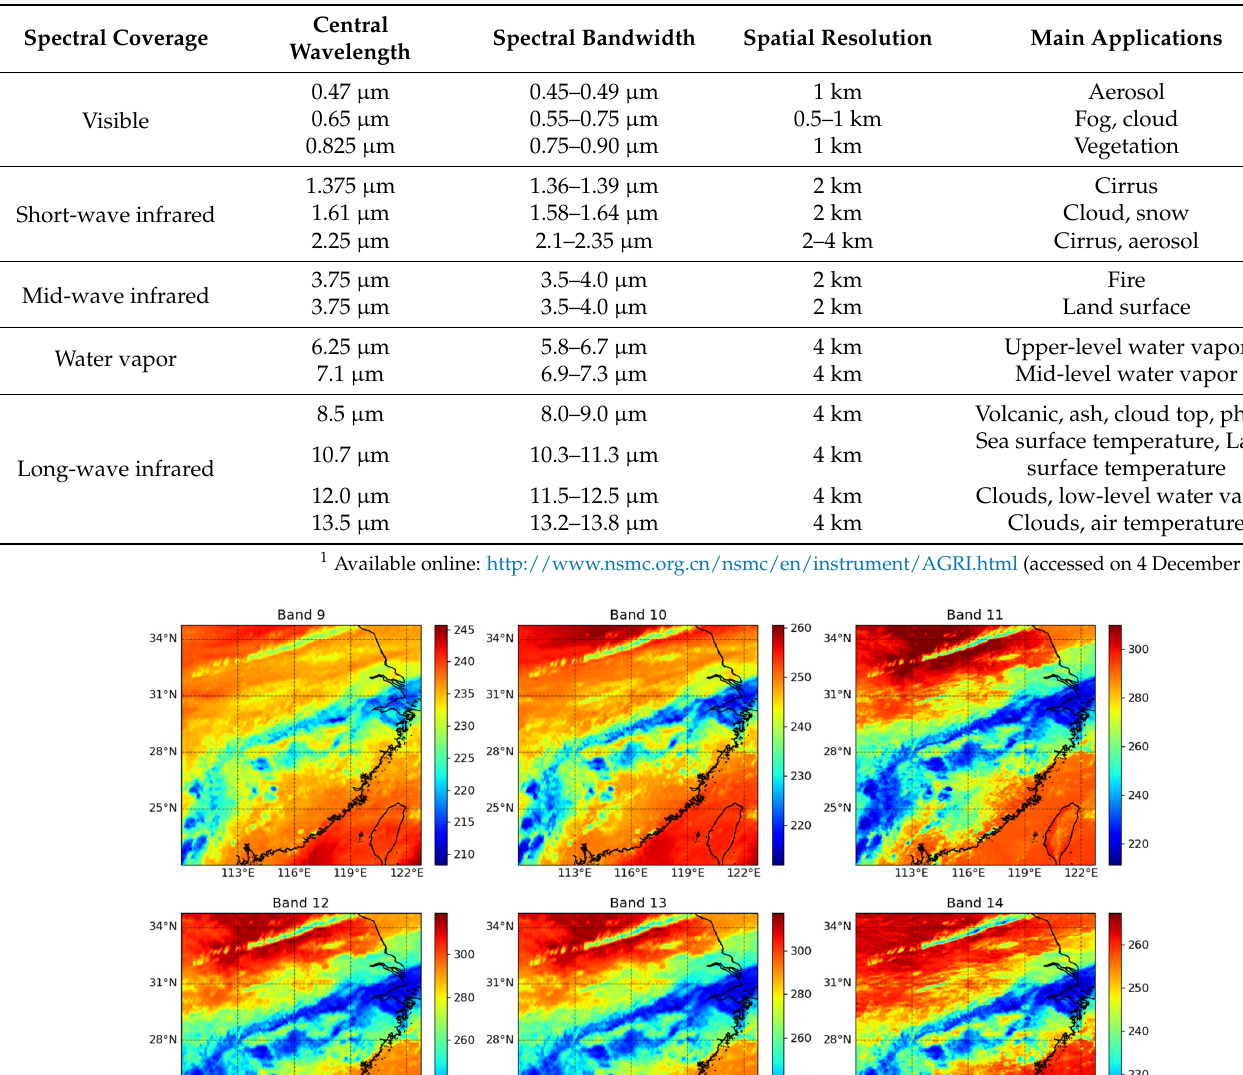
Table 1. The AGRI band observation information of the FY-4A satellite 1 .